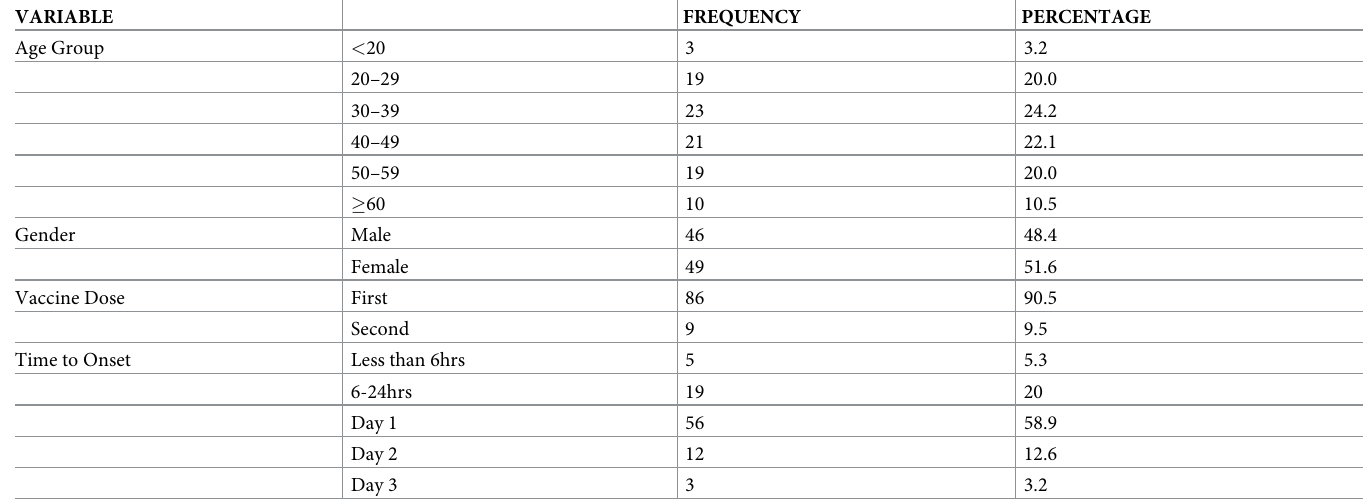
Table 1. Adverse event by age group, gender, dose, and time to onset (N = 95).